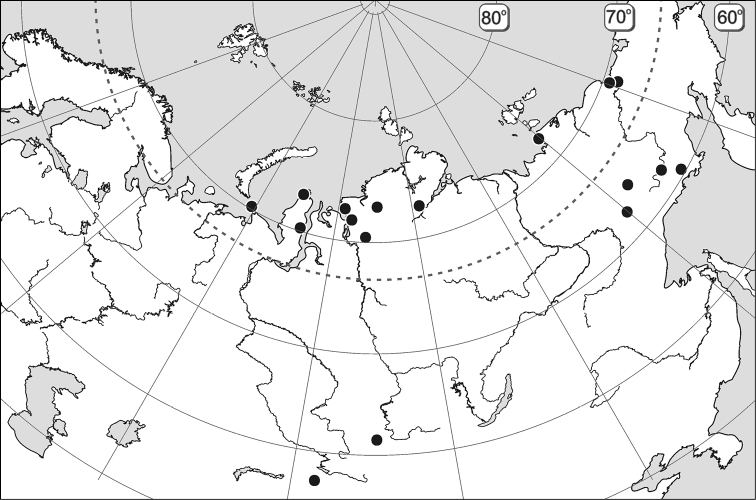
Records ofMaxinia arctomontana gen. et sp. n.